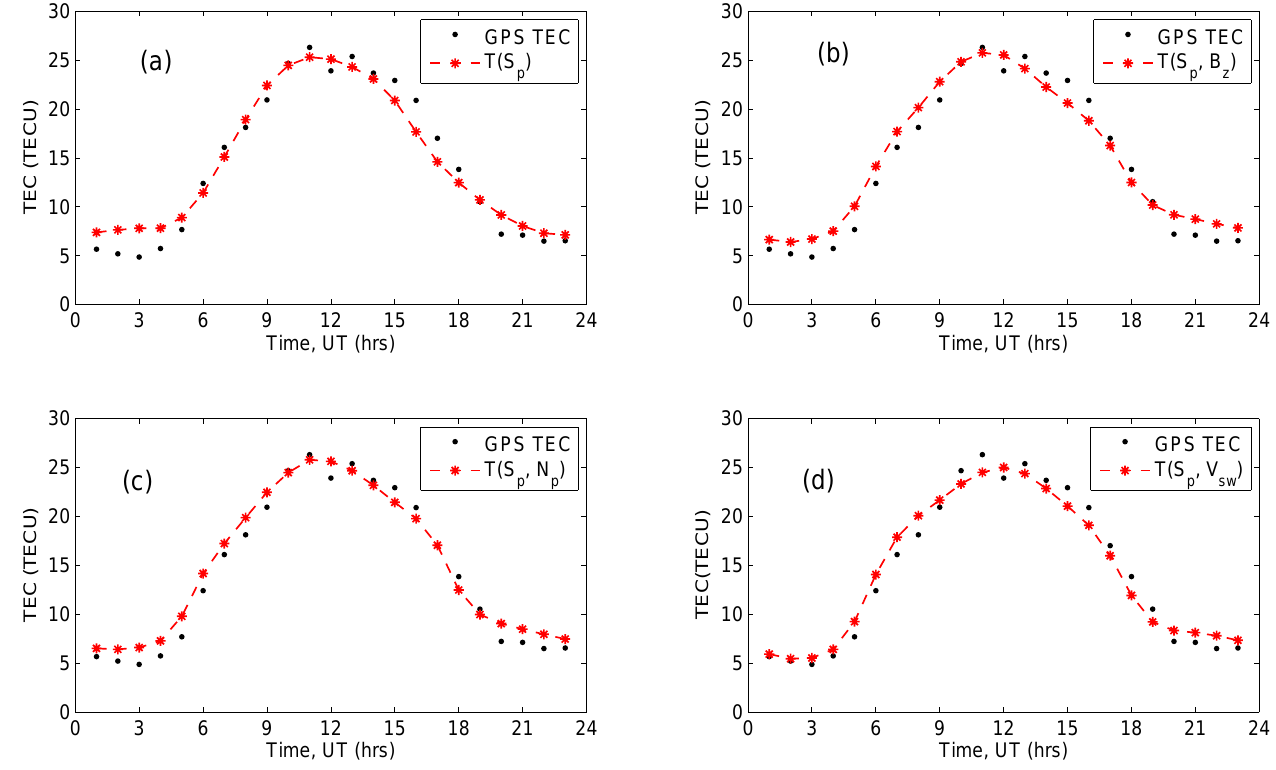
Fig. 3. Comparison between hourly GPS TEC and the corresponding predictions for (a) T (S p ), (b) T (S p , B z ), (c) T (S p , N p ) and (d) T (S p , V sw ); for day 58 in